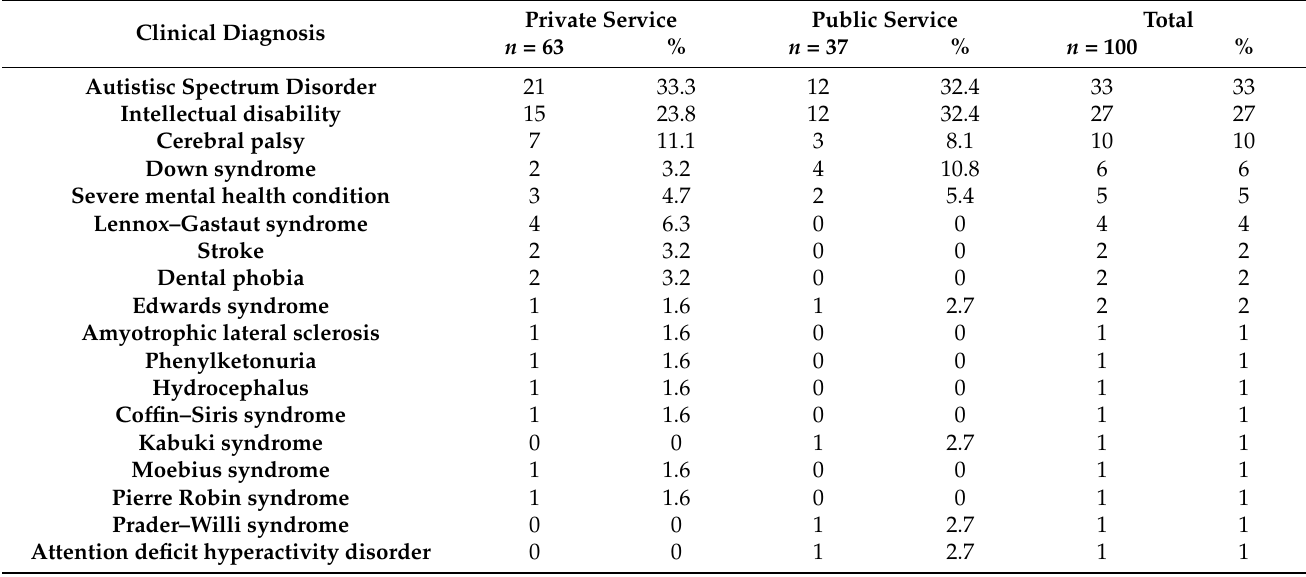
Table 2. Sample distribution attributed to primary clinical diagnosis.